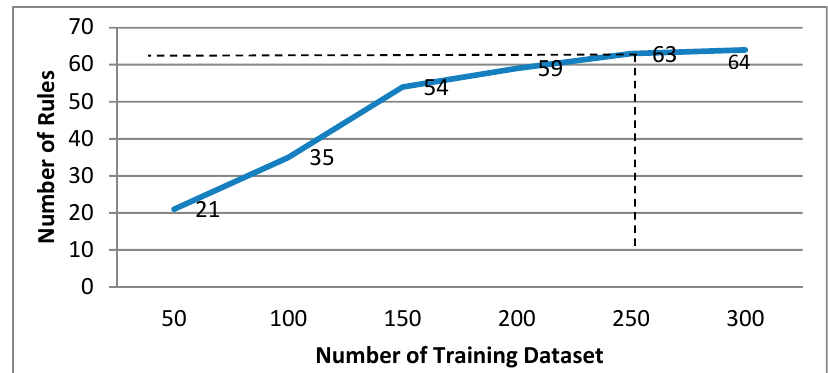
Figure 6. Optimized number of review sentences to train the aspect-sentiment pair extraction model.